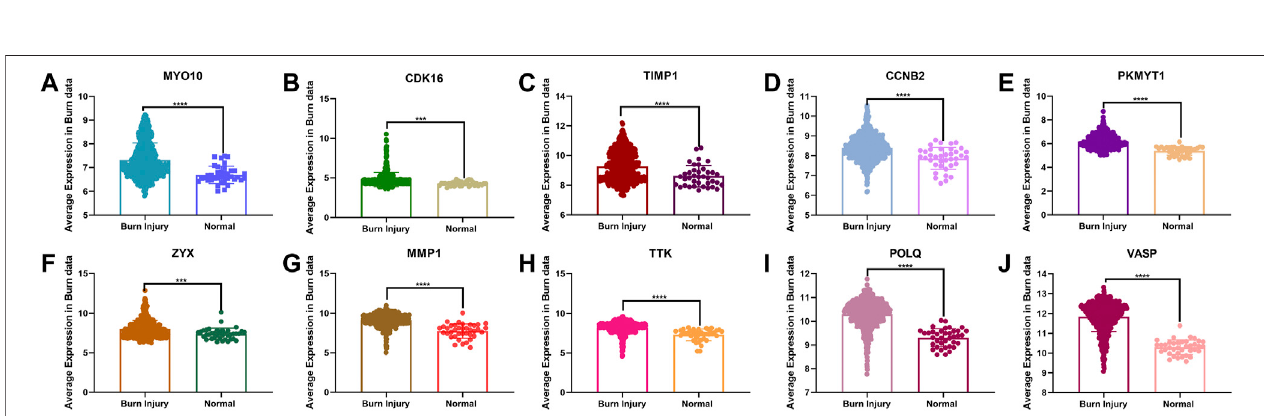
FIGURE 7 | (A – J) Comparison of the expression levels of 10 hub genes between normal and burn injury groups.